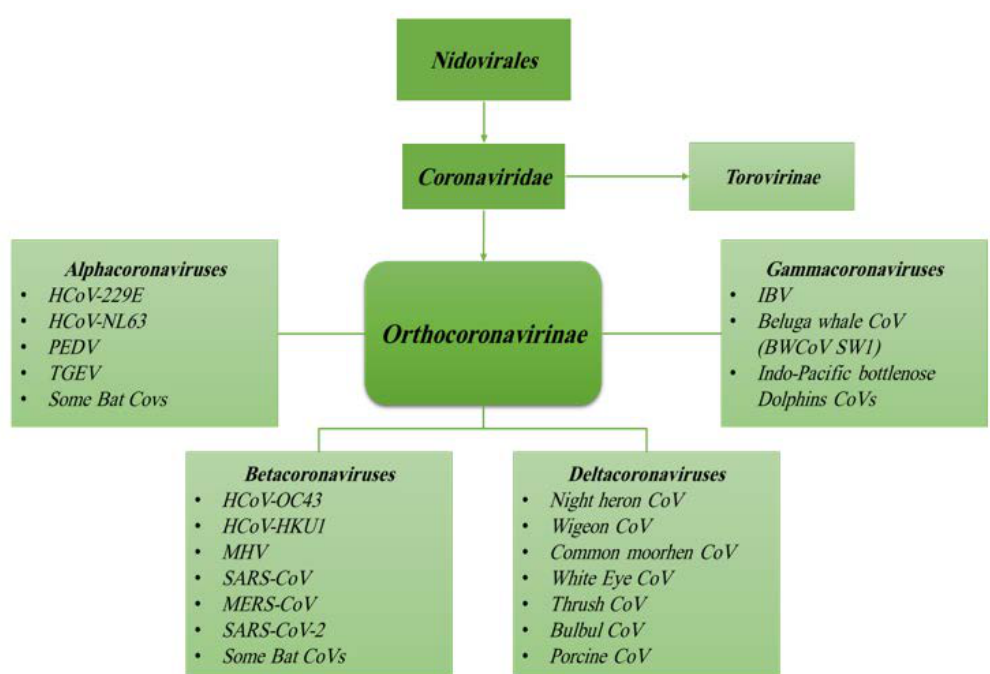
Figure 1. Classic subgroup clusters of coronaviruses within the family Coronaviridae , subfamily Orthocoronavirinae and the respective genera: Alphacoronavirus , Betacoronavirus , Gammacoronavirus and Deltacoronavirus .